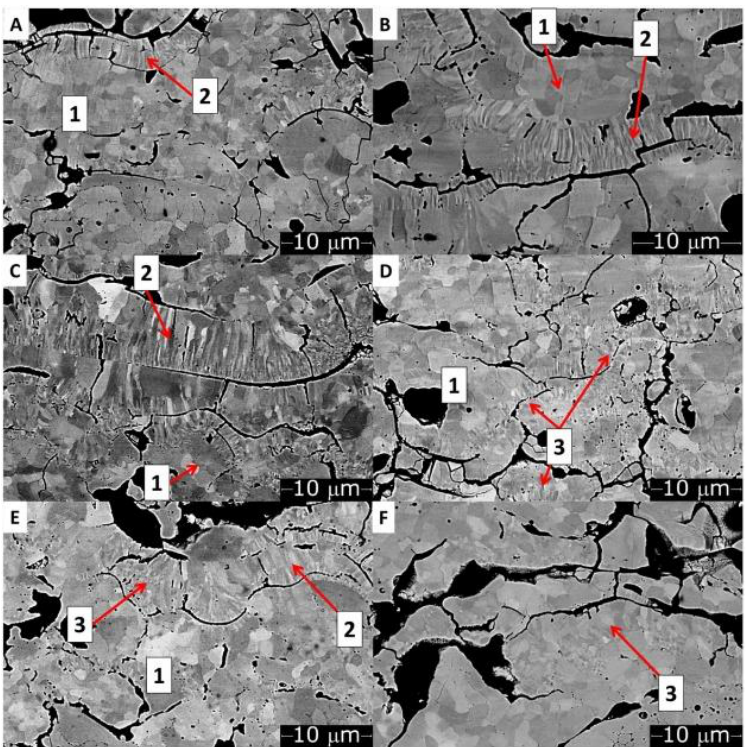
Figure 3. Low-porosity YSZ coating observed on BSE-SEM with equiaxed grains (Label 1), columnar grains (Label 2), and recrystallized columnar grains (Label 3). ( A – F ) represent the thermal cycles in increasing order. Reprinted with permission from [17]. Copyright 2019 Elsevier Ltd.